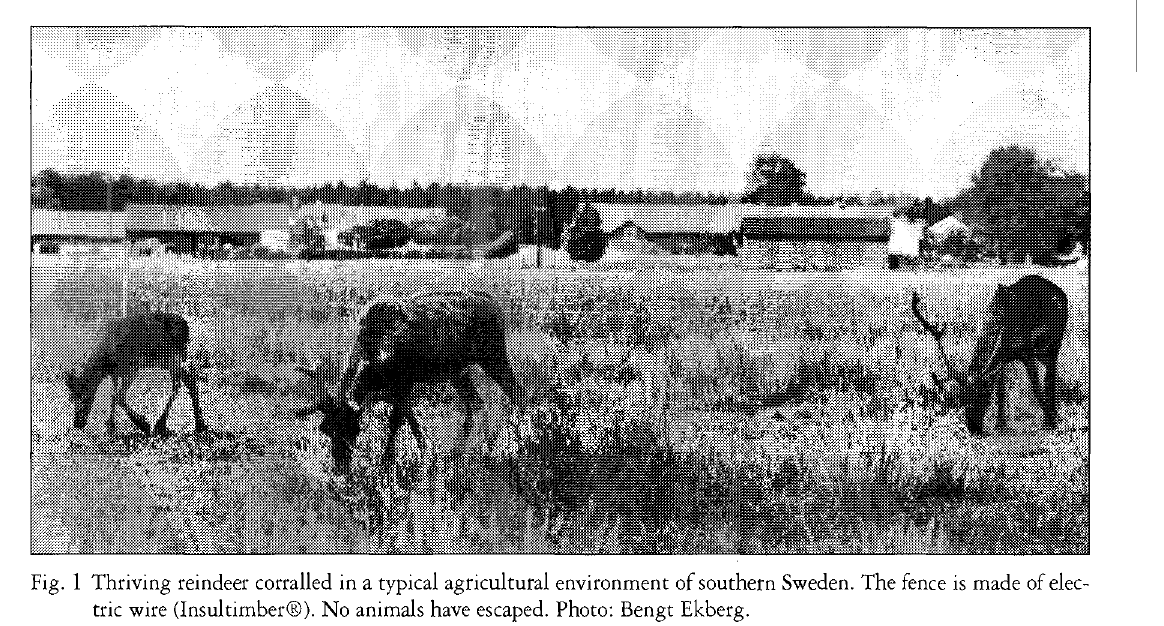
Fig. 1 Thriving reindeer corralled in a typical agricultural environment of southern Sweden. The fence is made of elec tric wire (Insultimber®). No animals have escaped. Photo: Bengt